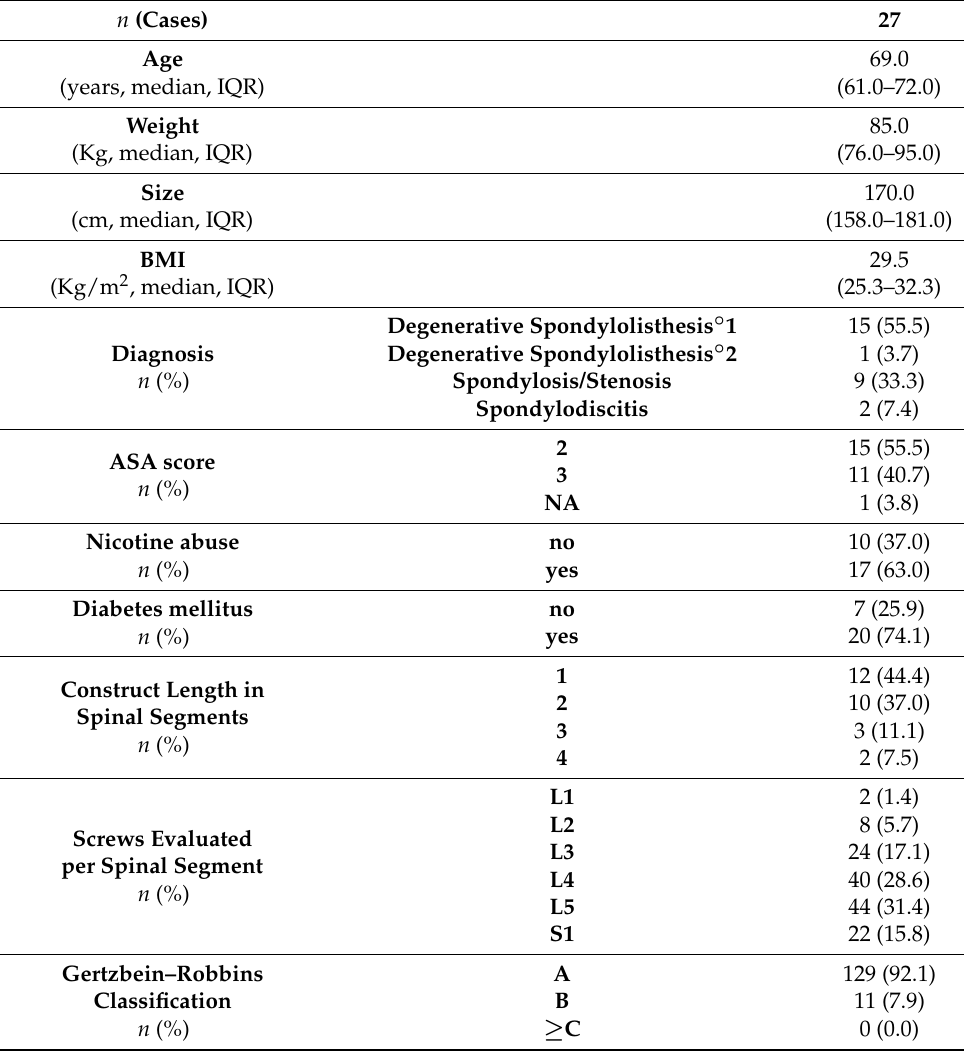
Table 1. Demographics.